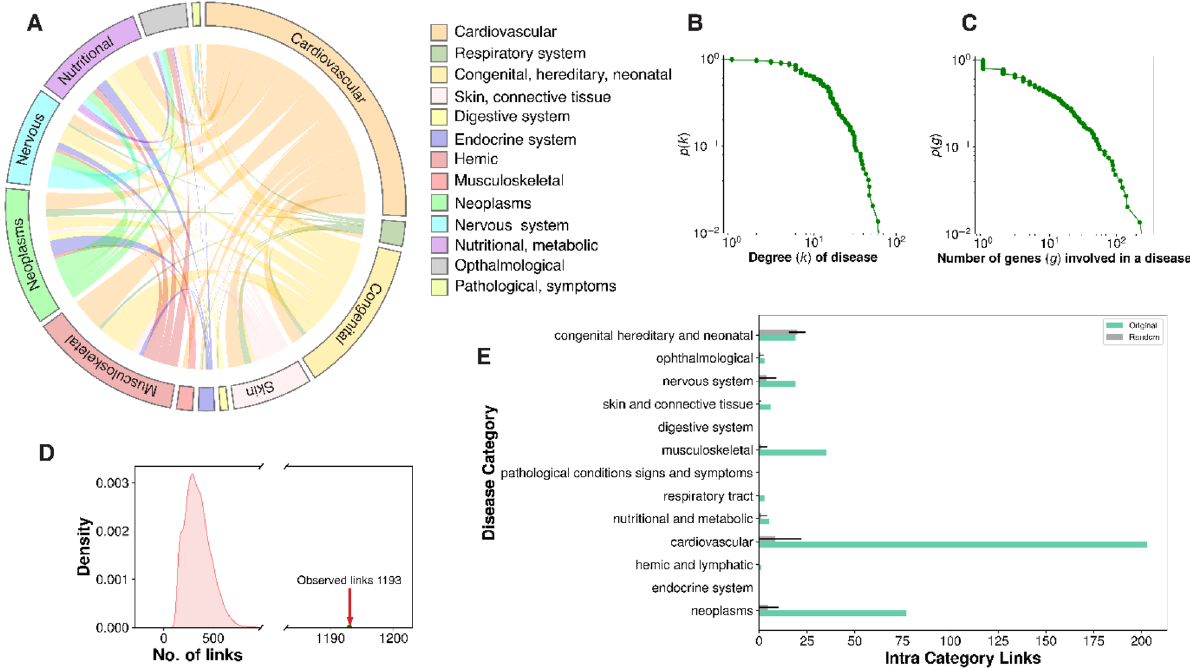
Figure 2. Diseasome properties: Overview of the cardiomyopathy-centric diseasome network. ( A ) Circos plot showing the inter disease category association of diseases in the cardiomyopathy-centric diseasome network. The names of the 12 disease classes are shown on the right and coloured accordingly. ( B ) Distribution of the degree k (number of diseases sharing common genes) in cardiomyopathy diseasome. The green dots represent the logarithmically binned data. ( C ) Distribution of the gene size g (number of genes implicated in a particular disease) in the cardiomyopathy-centric diseasome. ( D ) Number of disease links in the cardiomyopathy-centric diseasome versus random expectation. ( E ) Intra-disease category links distributions for real data and random trials. Green bars represent real data while gray bars show average intra-disease category links in the random trials. Error bars denote standard